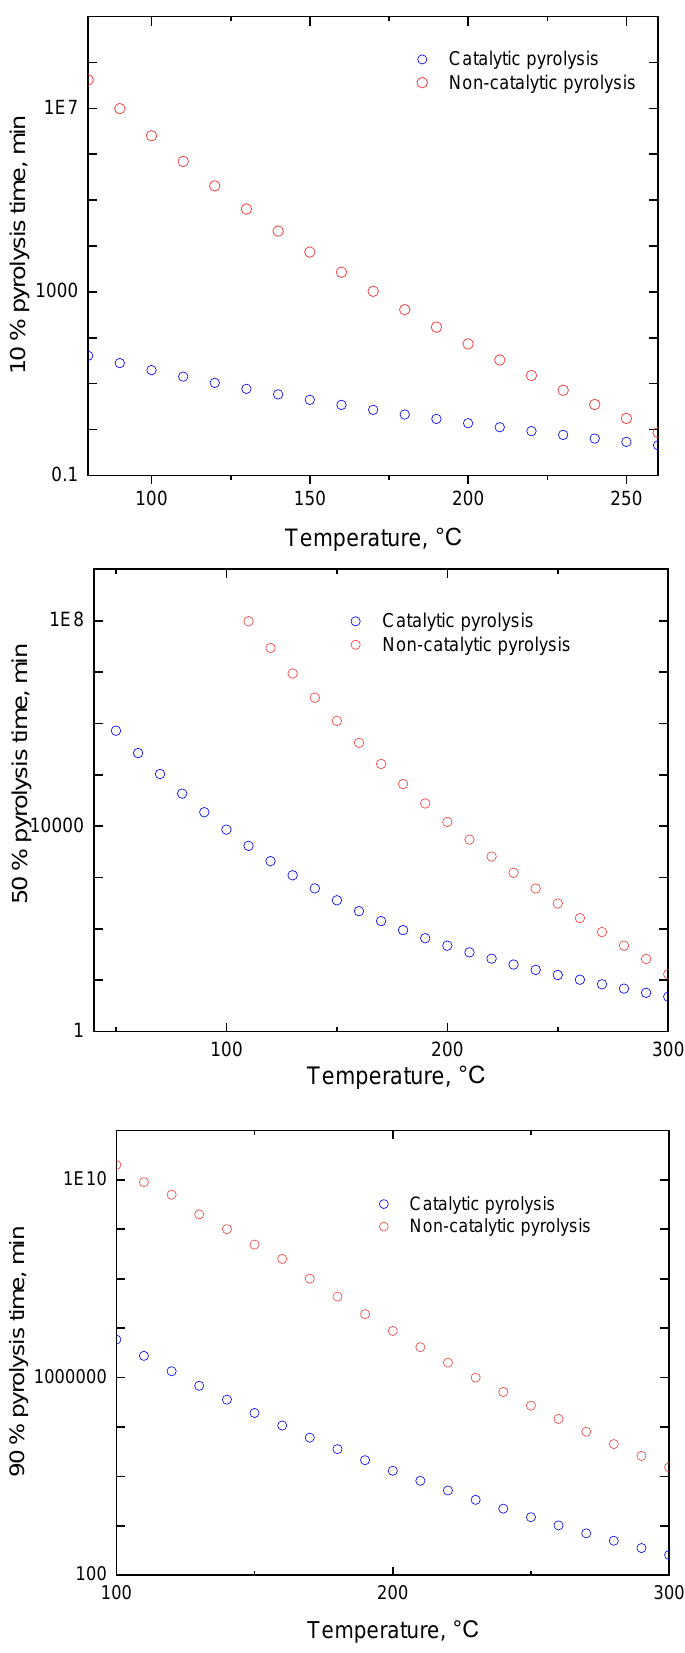
Figure 4. Calculated pyrolysis times of peat in the presence and absence of catalyst at 10%, 50%, and